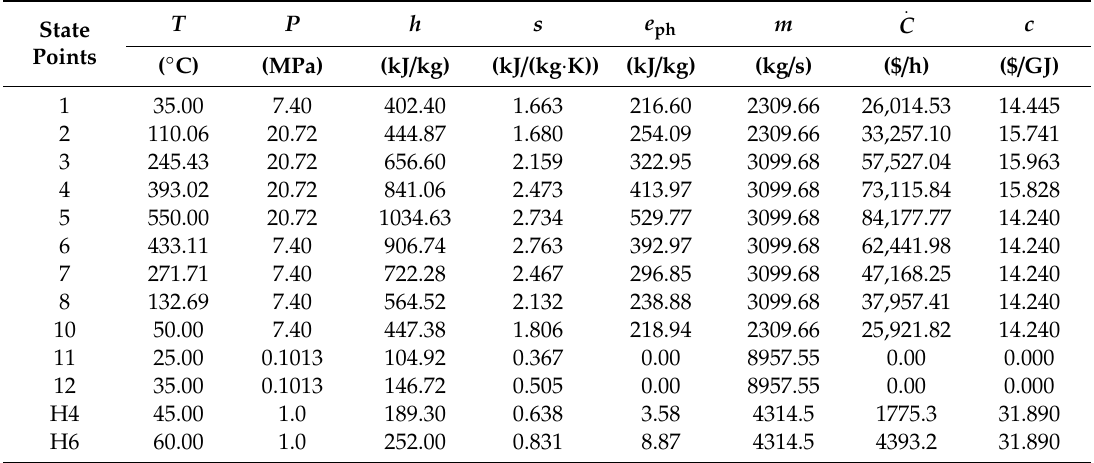
Table 12. Thermodynamic properties and costs of exergy streams for the sCO 2 / DH